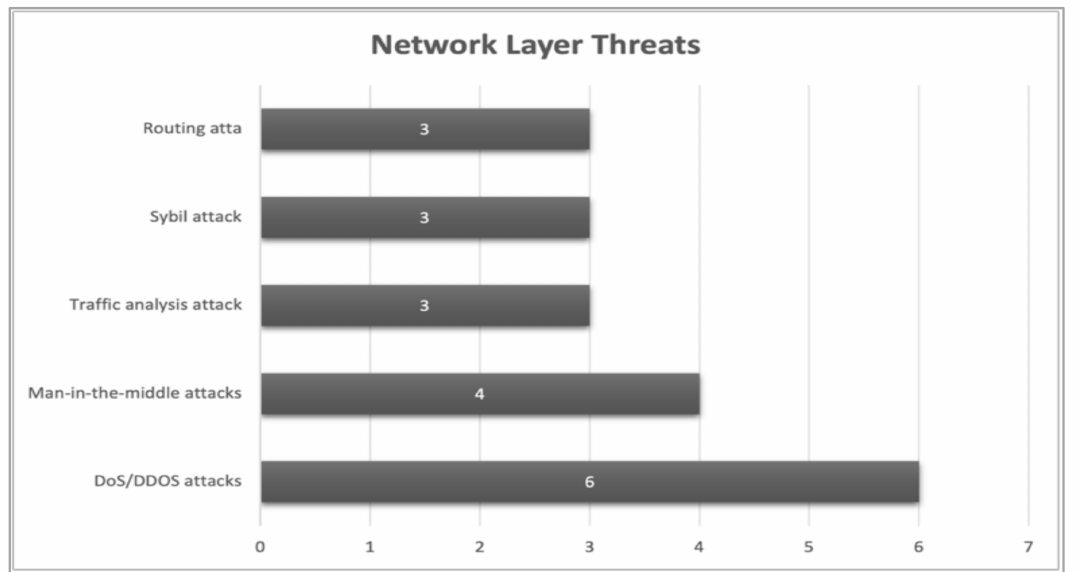
Figure 7. Common threats in the network